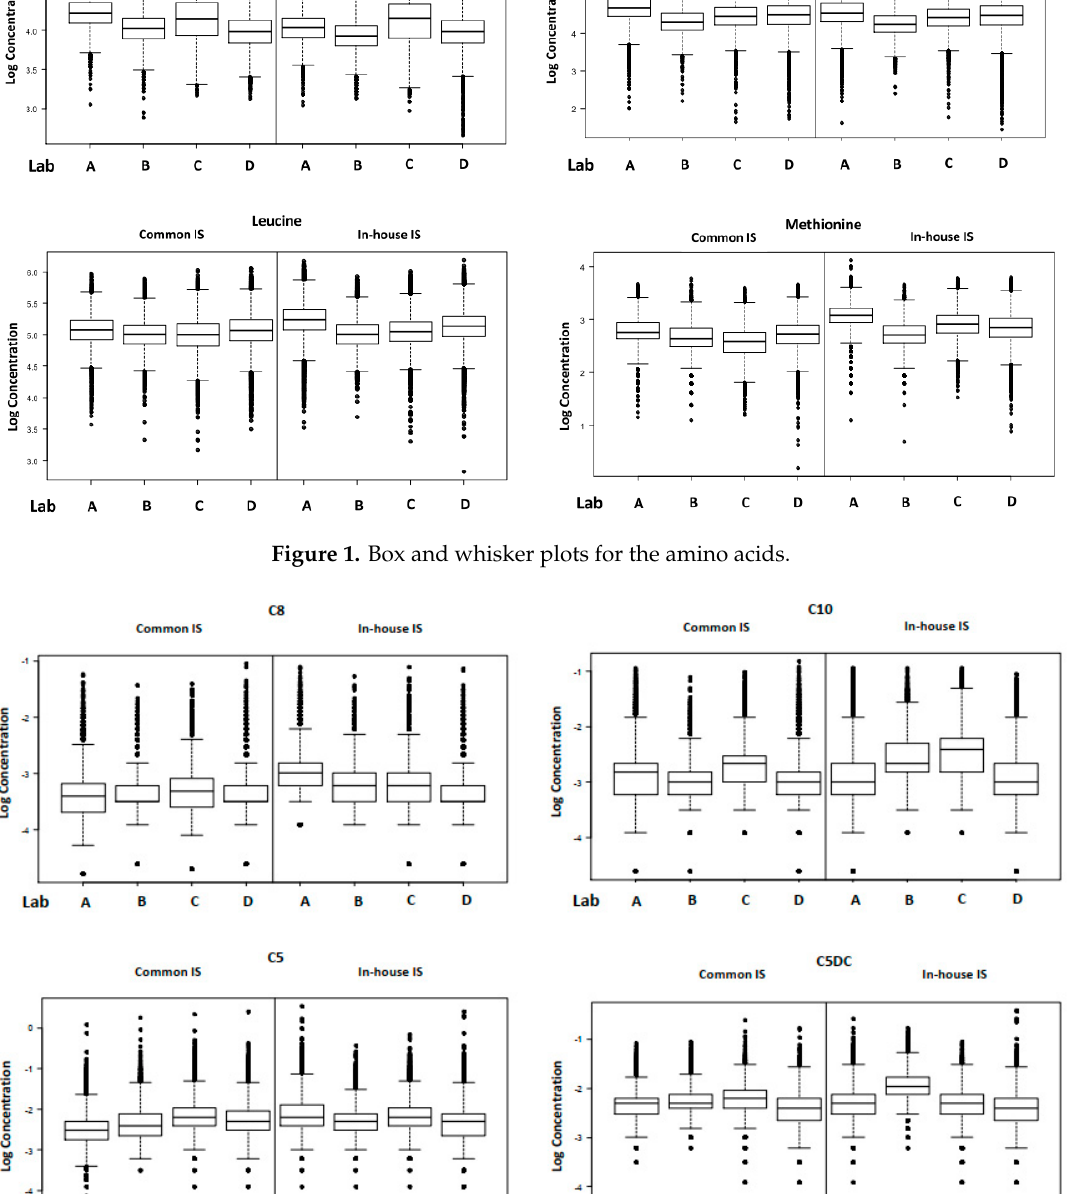
Figure 2. Box and whisker plots for the acylcarnitines.